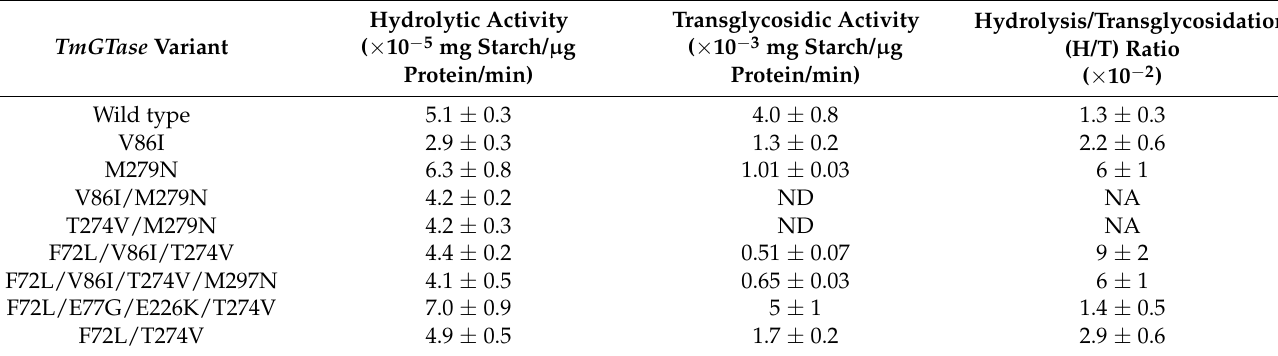
Table 2. TmGTase variants specific